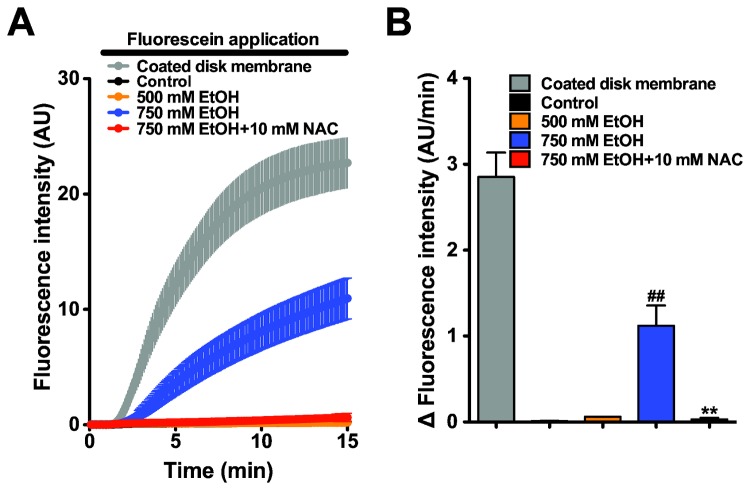
Ethanol increases the leakage of PDEC monolayers.(A) After ethanol treatment of PDEC monolayers for 4 h, their permeability was determined by perfusing fluorescein into the luminal chamber. Coated disk membranes (N = 6) without cells represent the maximum permeability, while untreated control monolayers (N = 4, overlapped with 500 mM ethanol and therefore invisible) and the monolayers treated with 500 mM ethanol (N = 4) had low permeabilities, i.e. tight monolayers. Monolayers treated with 750 mM ethanol (N = 6) had a higher permeability to fluorescein. Treatment of PDEC monolayers with 10 mM NAC 30 min before and during 750 mM ethanol (N = 3) prevented monolayer leakage. (B) Average rate of fluorescence intensity crossing the monolayers. The rate was estimated from the initial slop between 2 and 8 min. ##
p < 0.01 compared with the control group. ** p < 0.01 compared with 750 mM ethanol-treated monolayers. AU, arbitrary unit. The average and error for control are very small at this scale and therefore invisible.